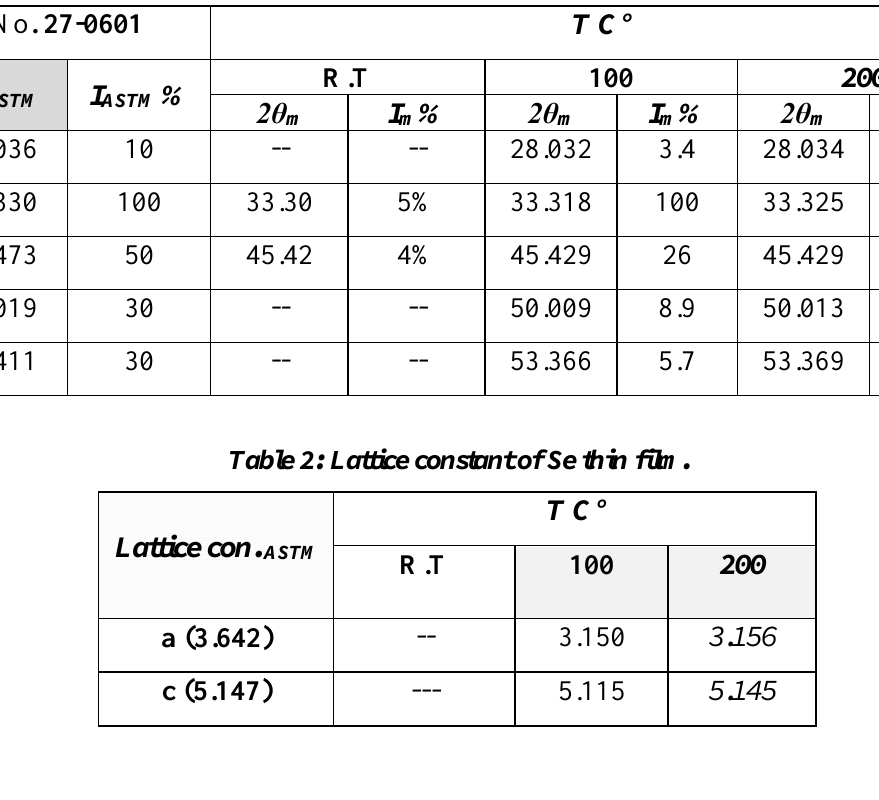
Table 1: XRD data selenium thin film as depositedand annealed at different temperature.